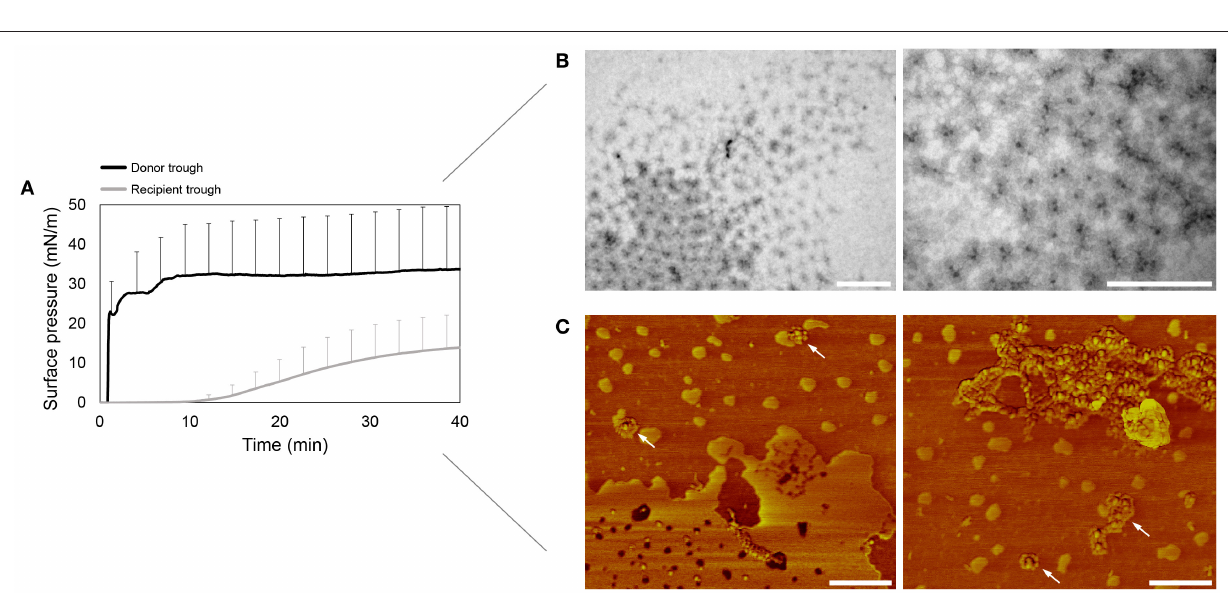
FIGURE 2 | Pulmonary surfactant vehiculization of rhSP-D over the air-liquid interface. (A) Adsorption and spreading isotherm of a suspension of the organic extract from native surfactant (OE) reconstituted and mixed with rhSP-D at 1% protein/lipid (w/w) ratio. An aqueous aliquot of 15 µ L (50 mg/mL; 750 µ g) of the material were deposited dropwise at the donor interface in the double-Wilhelmy balance and changes in surface pressure were measured in both troughs. Mean and standard deviations were obtained from three replicates. (B) Transmission electron microscopy (TEM) micrographs of the rhSP-D fuzzy balls detected at the recipient air-liquid interface upon surfactant-promoted interfacial vehiculization. (C) rhSP-D vehiculized by surfactant detected at the recipient air-liquid interface by atomic force microscopy (AFM) phase images. Some examples of fuzzy balls are pointed with white arrows. Scale bar: